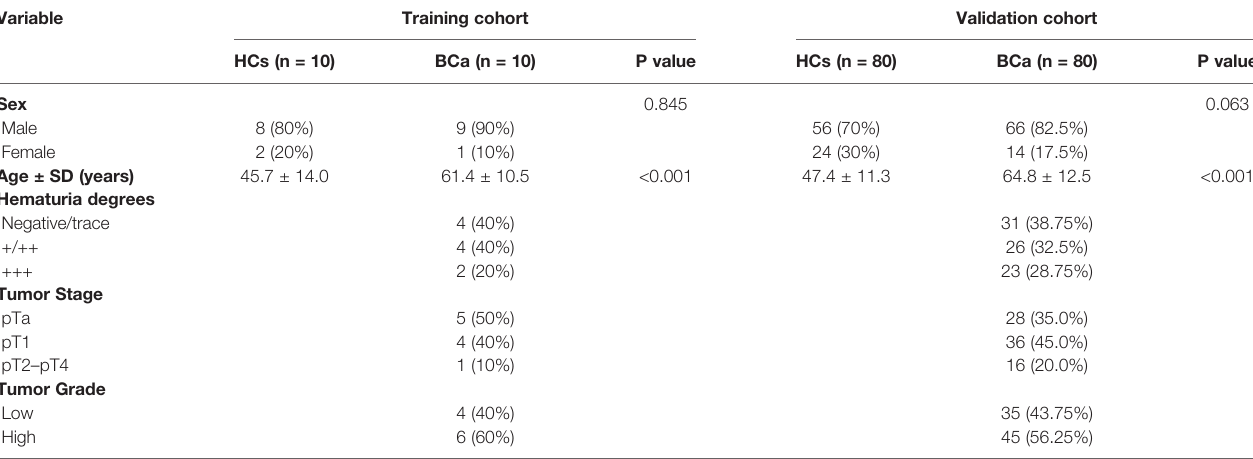
TABLE 1 | Demographic and clinical characteristics in training and validation